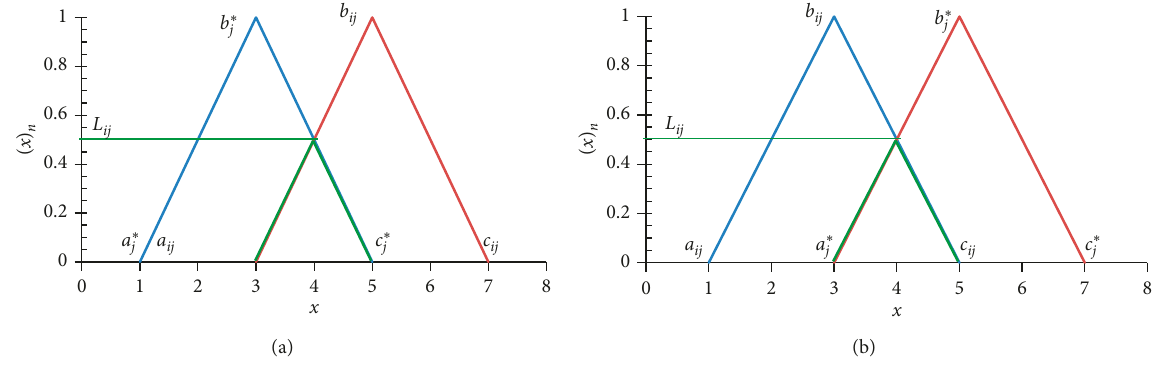
Figure 3: The intersection of two memberships ( L